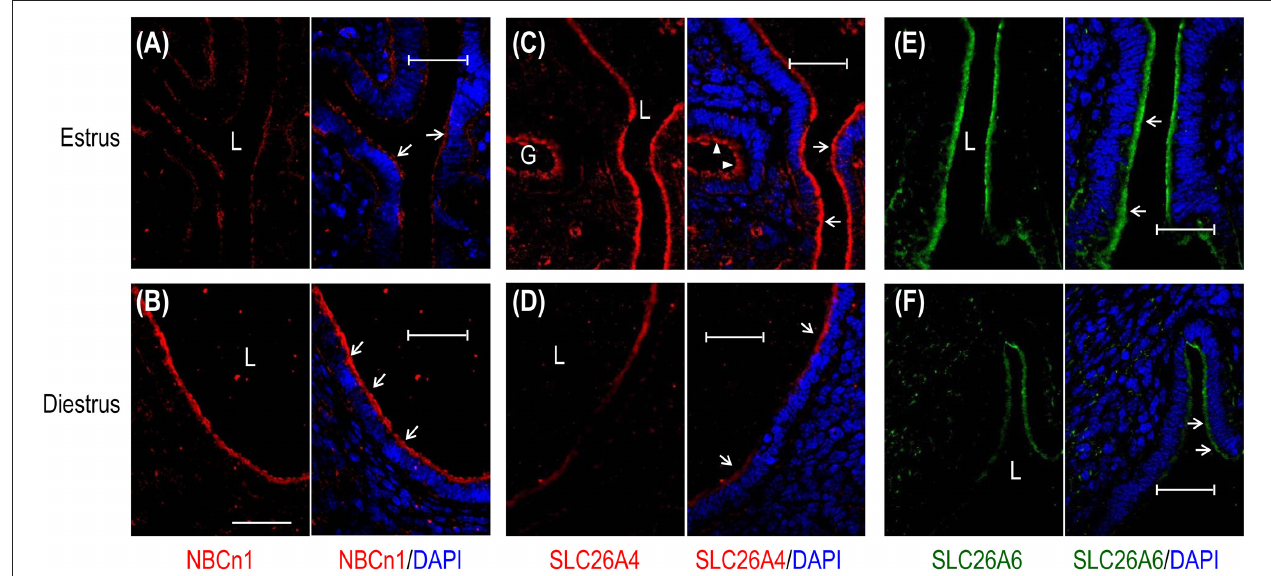
FIGURE 4 | Comparison of cellular expression of HCO − 3 transporters in mouse uteri at estrus vs. diestrus by indirect immunofluorescence. (A,B) NBCn1 in the uterus at estrus and diestrus. (C,D) SLC26A4 in the uterus at estrus and diestrus. (E,F) SLC26A6 in the uterus at estrus and diestrus. In these experiments, the sections were prepared from the uteri of mice that were sacrificed at typical estrus or diestrus stages as determined by cytological evaluation of the vaginal smears. To compare the expression of a given transporter at estrus vs. diestrus, immunofluorescence staining was performed in parallel with the sections of estrus and diestrus, and images were acquired with the same set of parameters on the confocal microscopy. L: uterus lumen; G: glandular duct. Arrows indicate the apical membrane of endometrial epithelium. Arrowheads indicate the apical membrane of glandular epithelium. Scale bars: 40 µ m. Results are representative of 3–4 independent experiments for each transporter with sections from one mouse at either estrus or